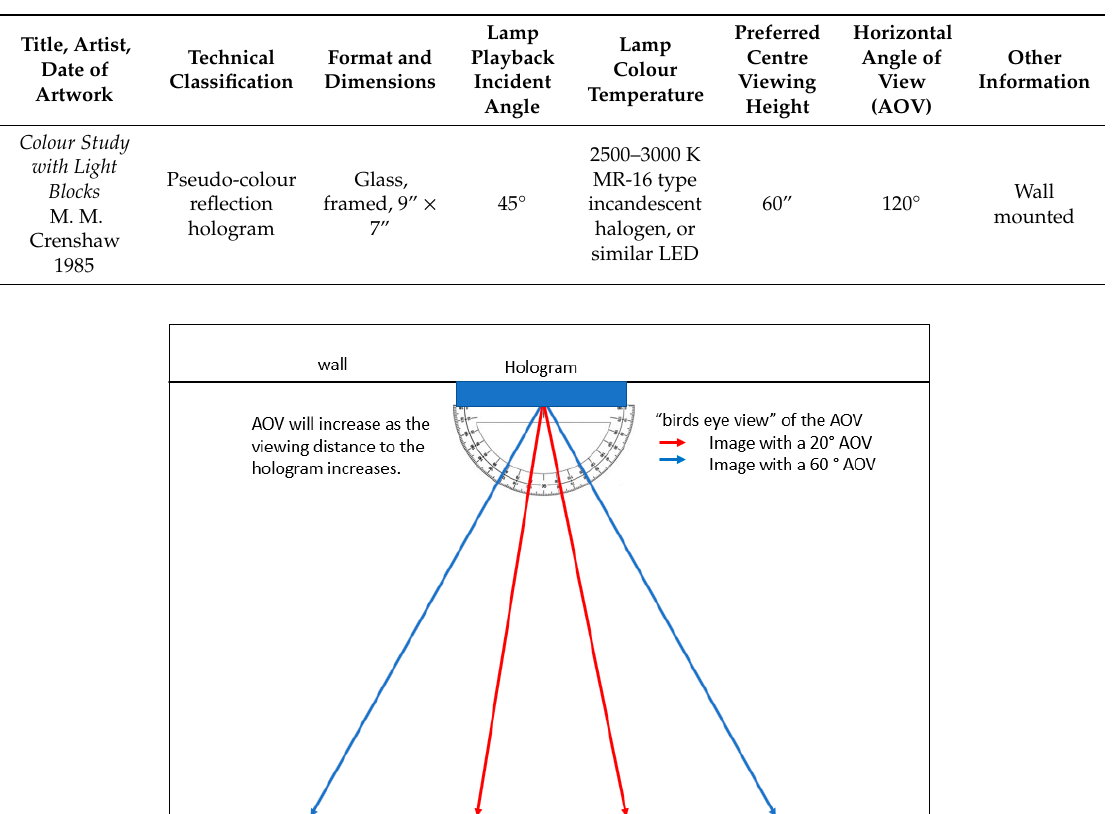
Table 1. Hologram Installation Guidelines.